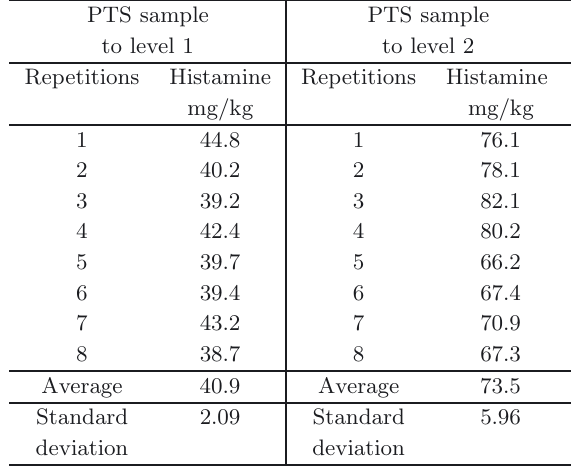
Table 6. Statistical balance of the laboratory network for the histamine amount (mg/kg), in the level 2 PTS sample. Parametric average: x = 73 . 3 Repeatability standard deviation: s r = 1 . 7 Repeatability coefficient of variation: Inter laboratories coefficient of variation: Reproductibility standard deviation: Reproductibility coefficient of variation: Number of laboratories after withdrawal of the abnormal: